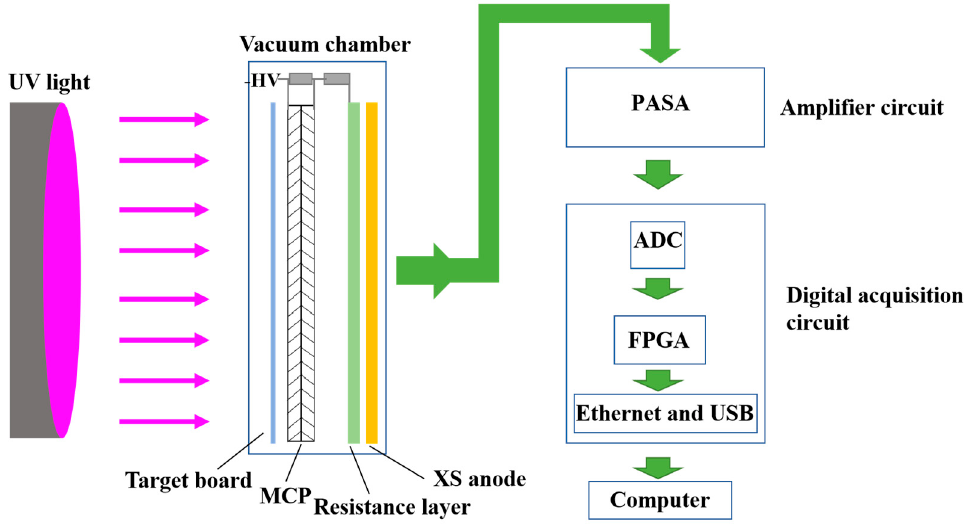
Figure 8. Schematic diagram of XS imaging test system.